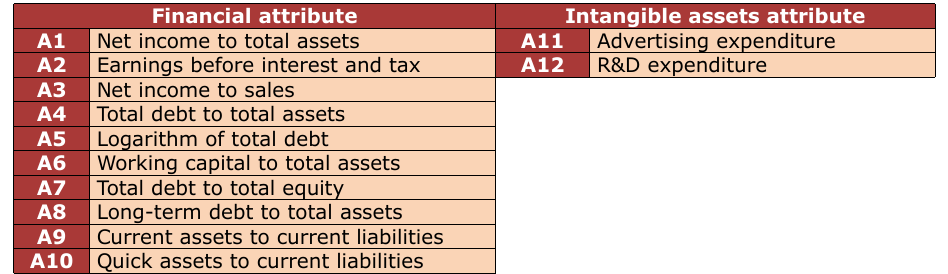
Table 1. The description of each attribute